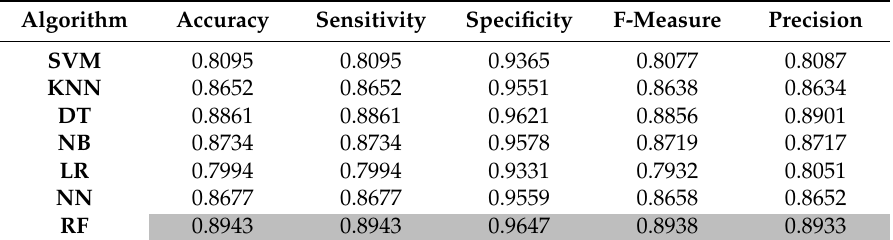
Table 5. Performance measures using 8 s window length with different